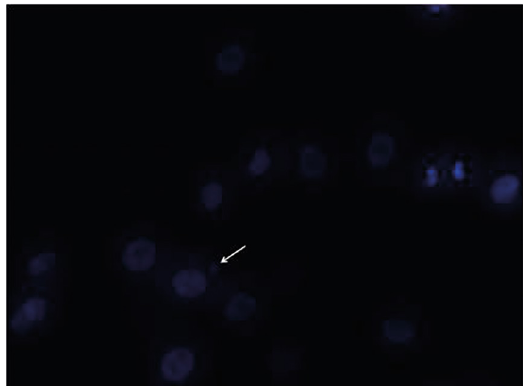
Figure 8. Photomicrography of MG-63 nuclei after contact of the cells with β-TCP/Al O – 85/15 for 24 hours. Note the presence 2 3 of a micronucleus (arrow) in this site (Fluroshield with DAPI Immunofluorescence staining; original magnification x20).